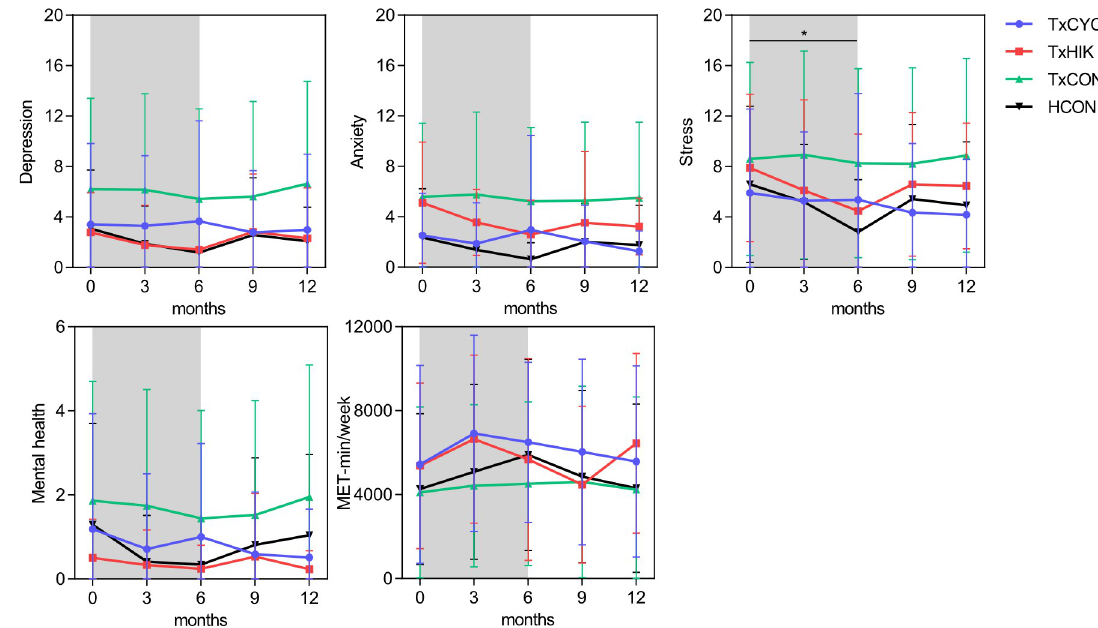
Fig 4. Depression, anxiety, stress, mental health, and physical activity (continuous score) for all groups at each time point. Line graphs are mean ± SD. Grey bar indicates the Transplantoux intervention. � P < 0.05 group x time interaction effect.